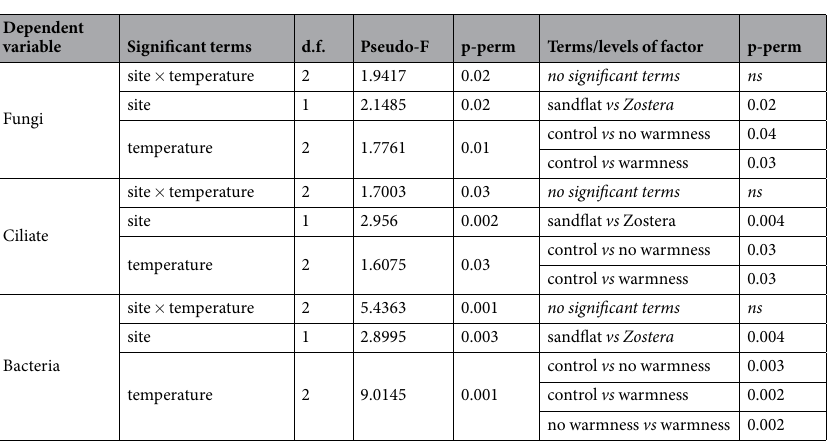
Table 3. Summary of significant terms from the 2-way PERMANOVA analyses with fungal, ciliate or bacterial communities as dependent variables, and site and temperature as explanatory variables, with indication of the significant pairwise